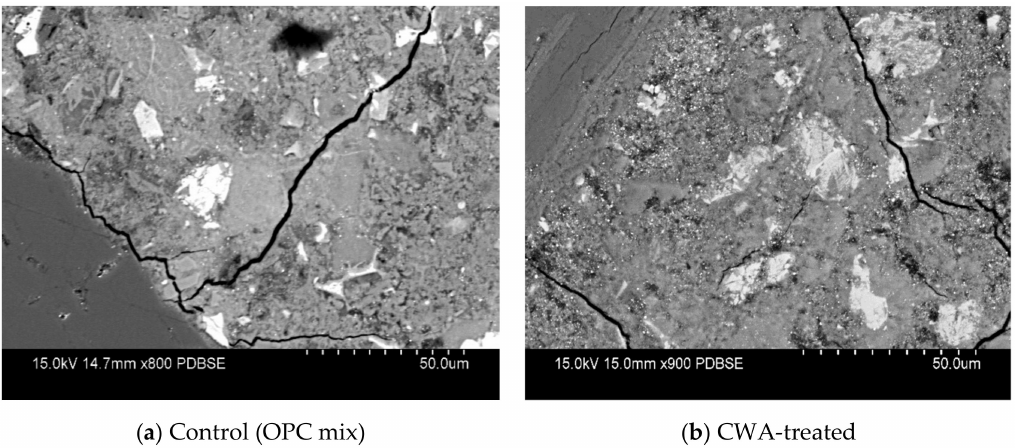
Figure 2. Back-scattered SEM images of ( a ) control and ( b ) CWA-treated samples indicating no crystal presence due to the harsh surface preparation